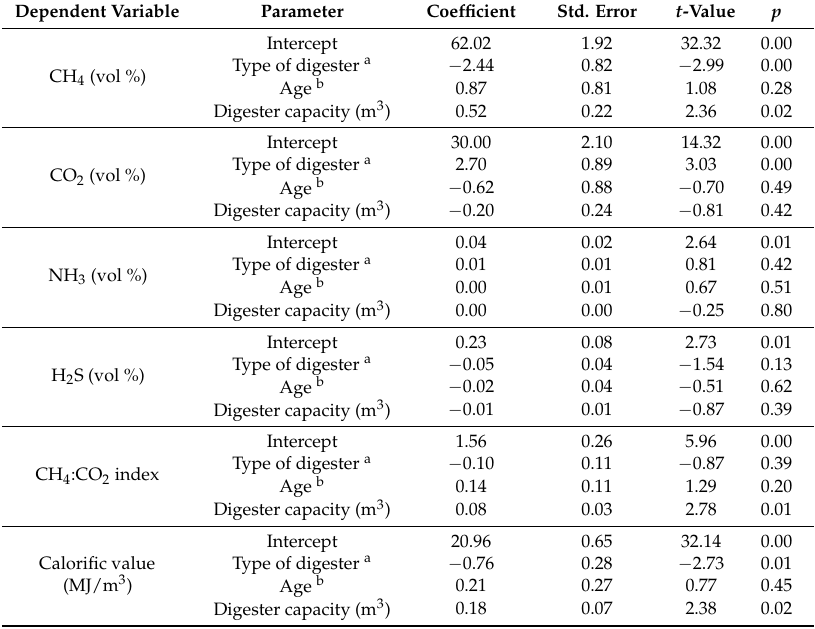
Table 6. Biogas composition as affected by type, age, and capacity of the biogas